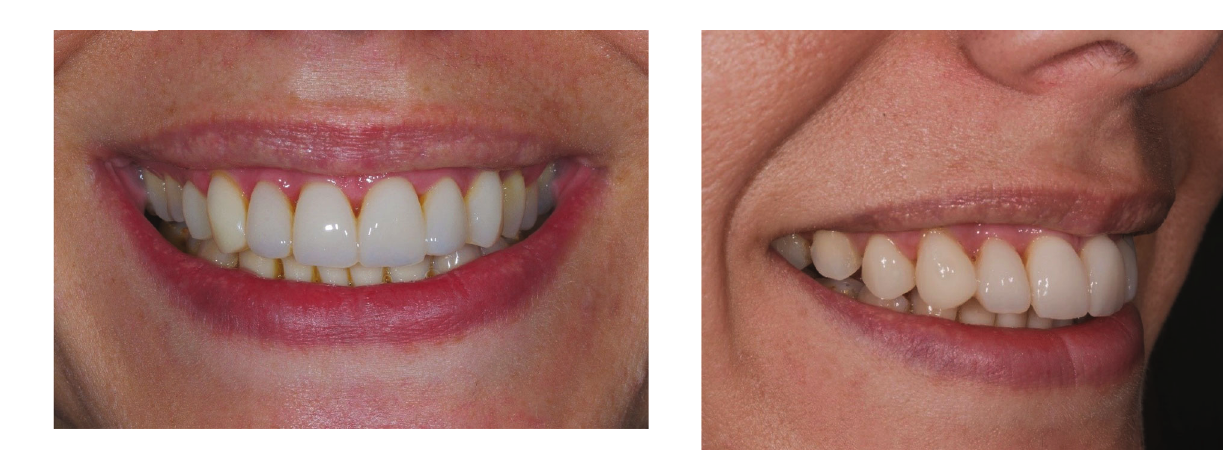
Figure 13: Clinical case: frontal view, at the end of the treatment.